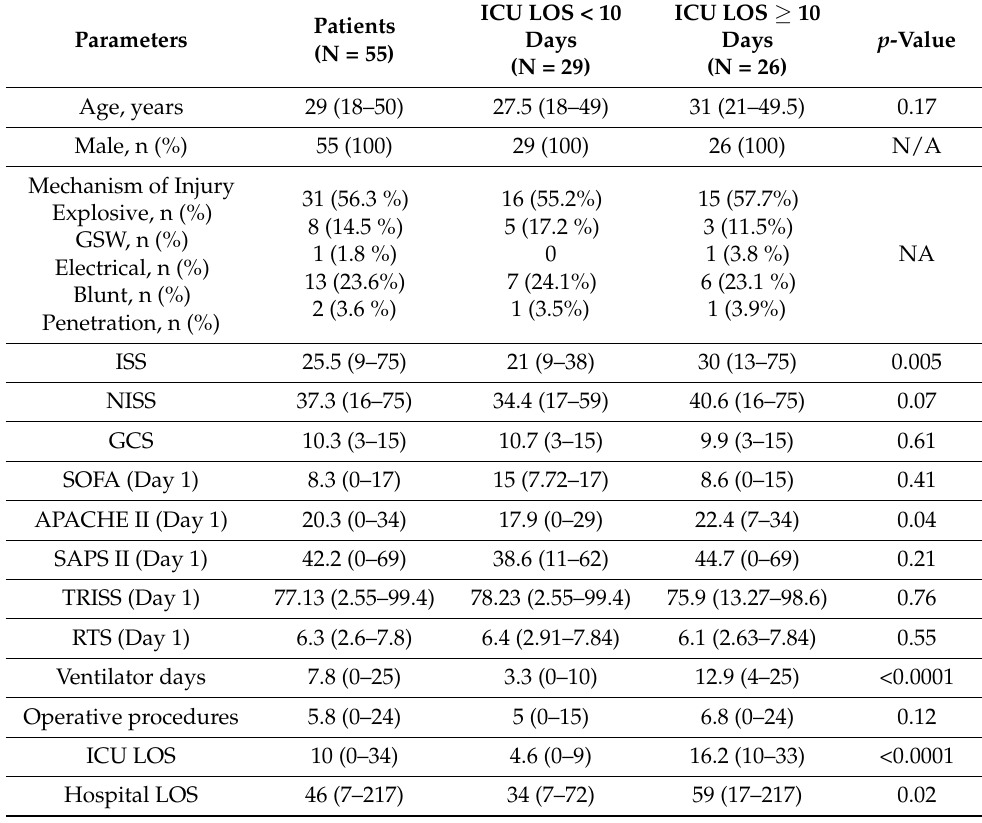
Table 1. Summary of the demographic and clinical characteristics of the study